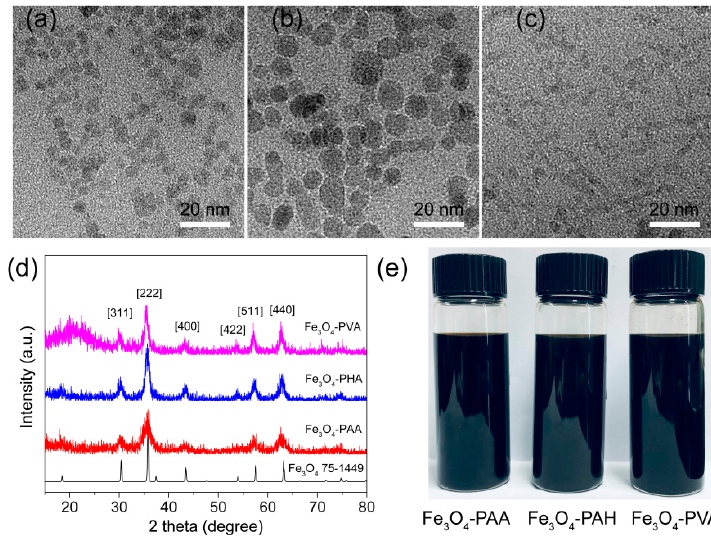
Figure 1. TEM images of ( a ) Fe 3 O 4 -PAA, ( b ) Fe 3 O 4 -PAH, and ( c ) Fe 3 O 4 -PVA. ( d ) PXRD of the Fe 3 O 4 powder standard with JCPDS Card No. of 75-1449, Fe 3 O 4 -PAA, Fe 3+ O 4 -PAH and Fe 3 O 4 -PVA. ( e ) Photographs of Fe 3 O 4 -PAA, Fe 3 O 4 -PAH and Fe 3 O 4 -PVA nanoparticles in aqueous suspension.